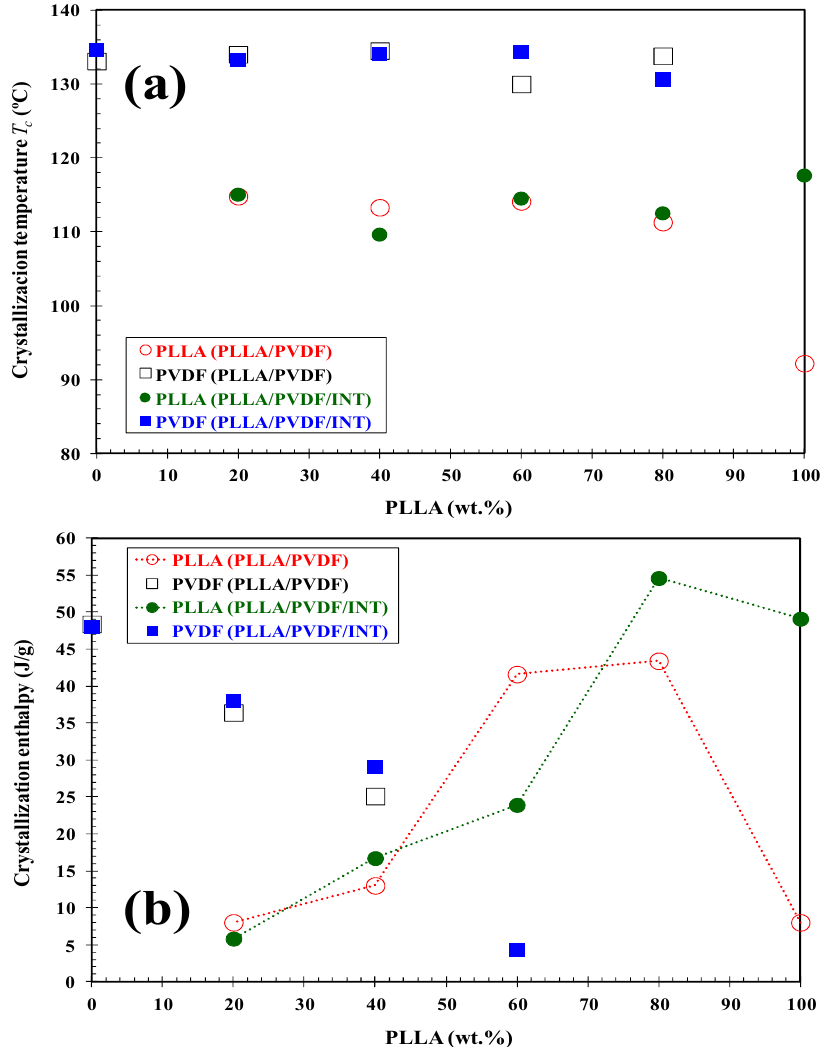
Figure 6. DSC thermograms of the non-isothermal crystallization of ( a ) binary PLLA/PVDF and ( b ) ternary PLLA/PVDF/INT-WS 2 hybrid nanocomposites obtained during cooling from the melt to room temperature at 10 °C/min.